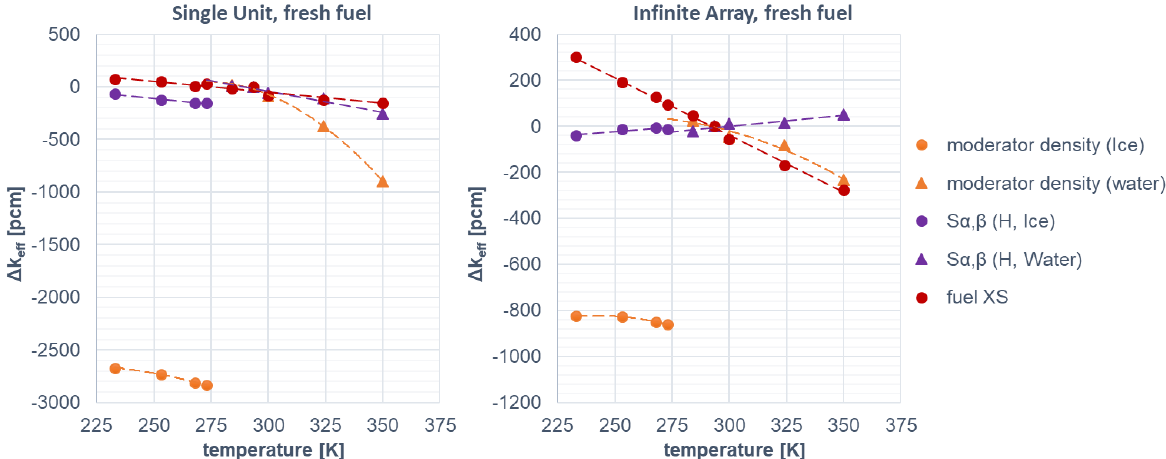
Figure 4. Temperature-dependent impact of the moderator density, the thermal scattering data of hydrogen (S ) and the reaction cross sections (XS) of the fuel on k α,β